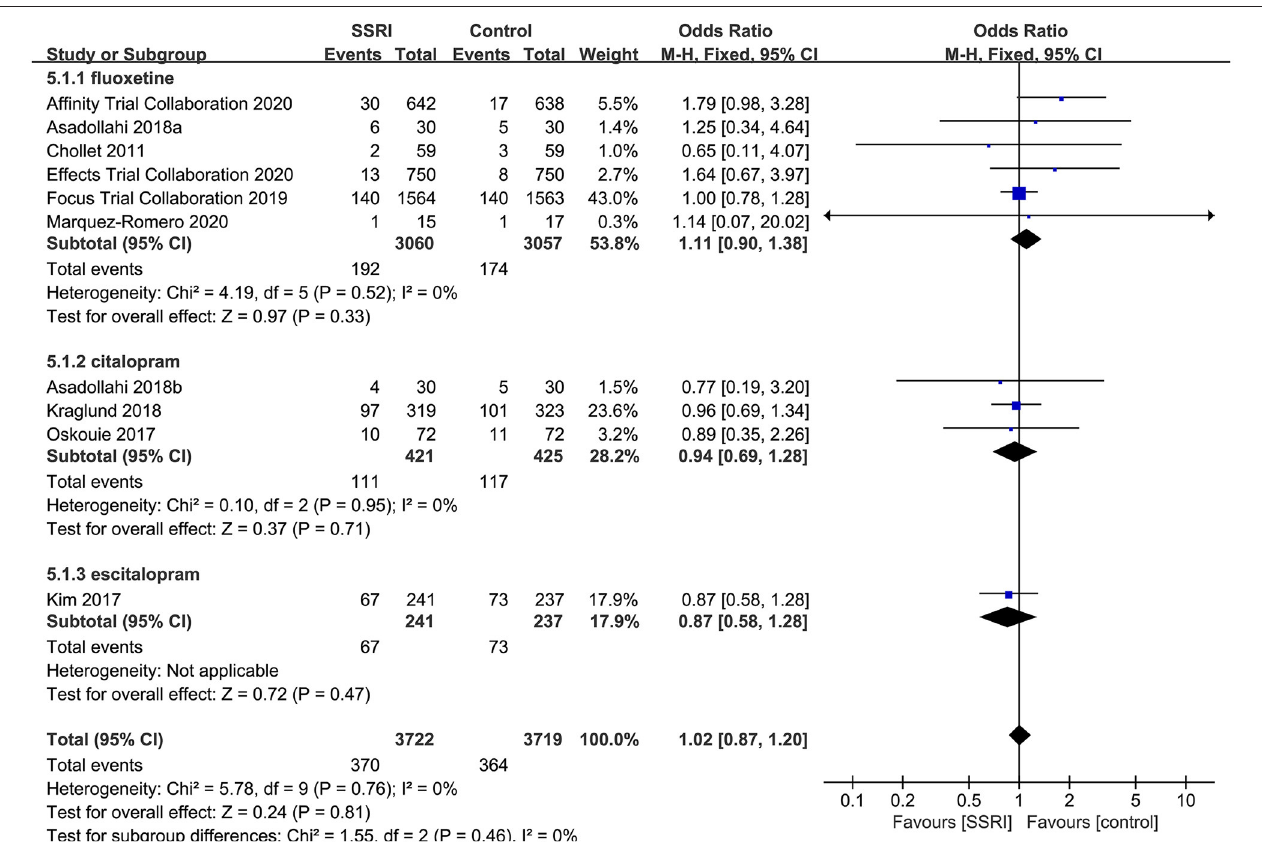
FIGURE 6 | Forest plot of total withdrawal